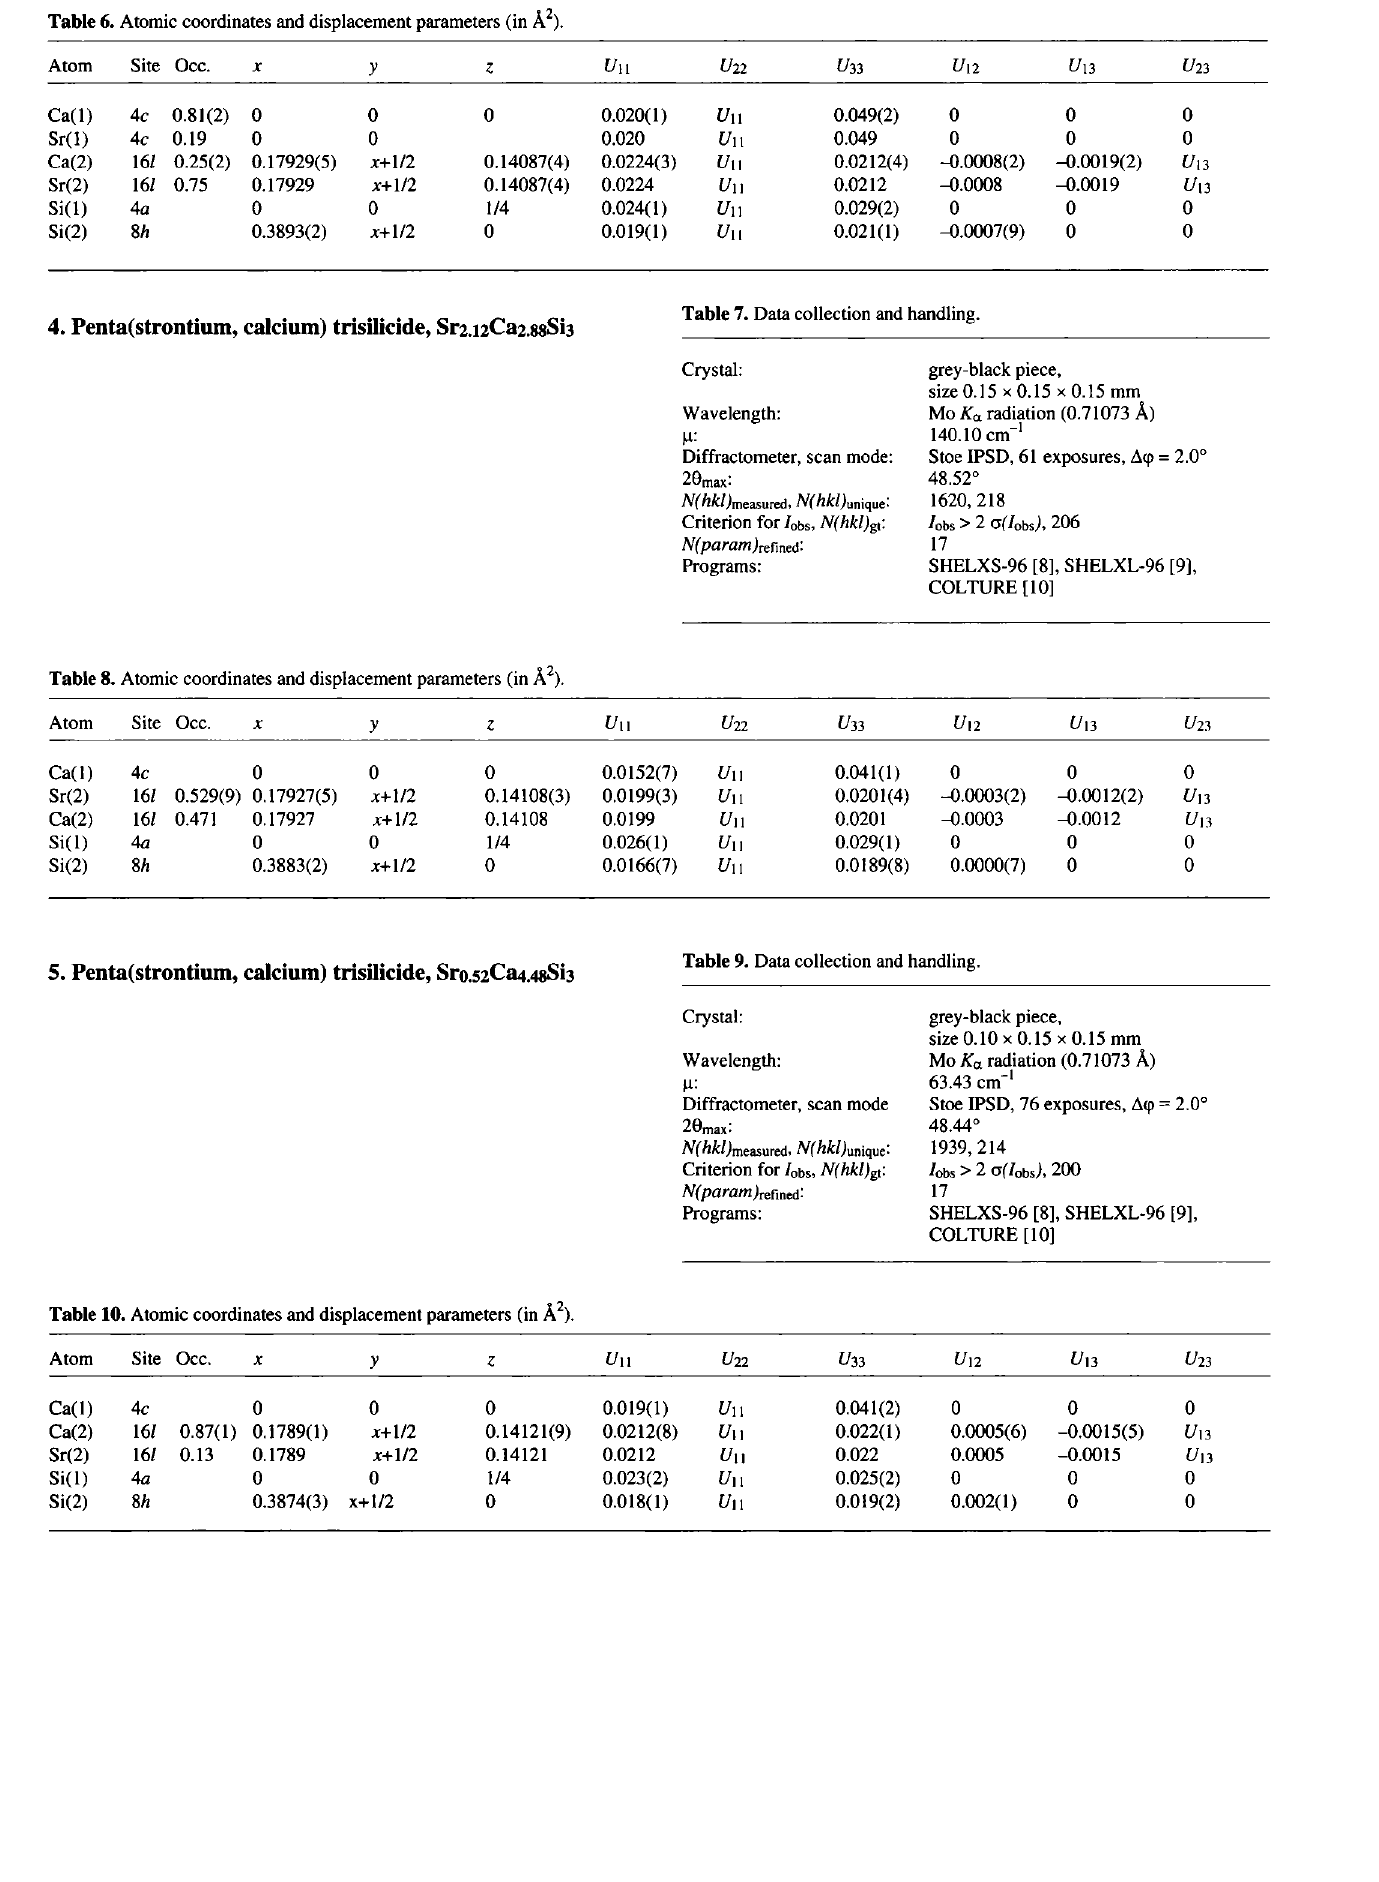
Table 6. Atomic coordinates and displacement parameters (in Ä 2 ). Atom